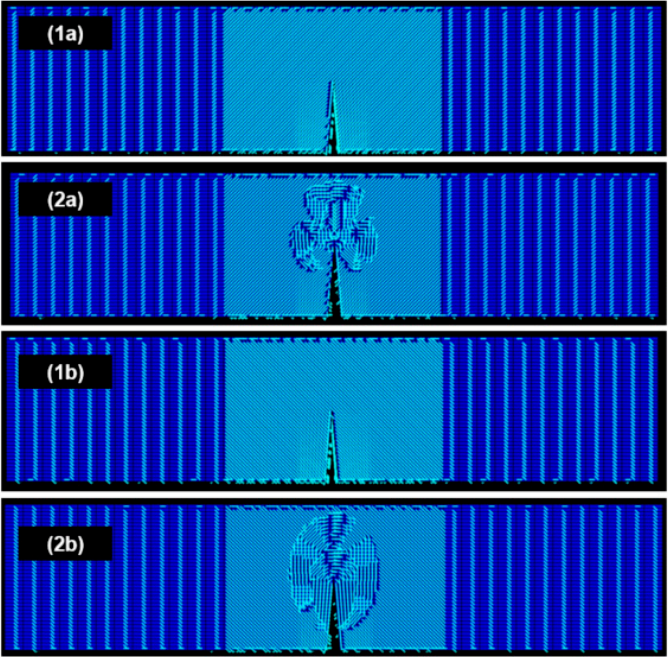
Figure 12. Numerical models of the SENB specimen. ( 1 ) Corresponds to the classical deposition with ±45° layers alternation. ( 2 ) For the optimized deposition with principal stress reproduction in the V notch tip vicinity; ( a ) denotes the first principal direction while ( b ) is for the second prin- cipal direction.